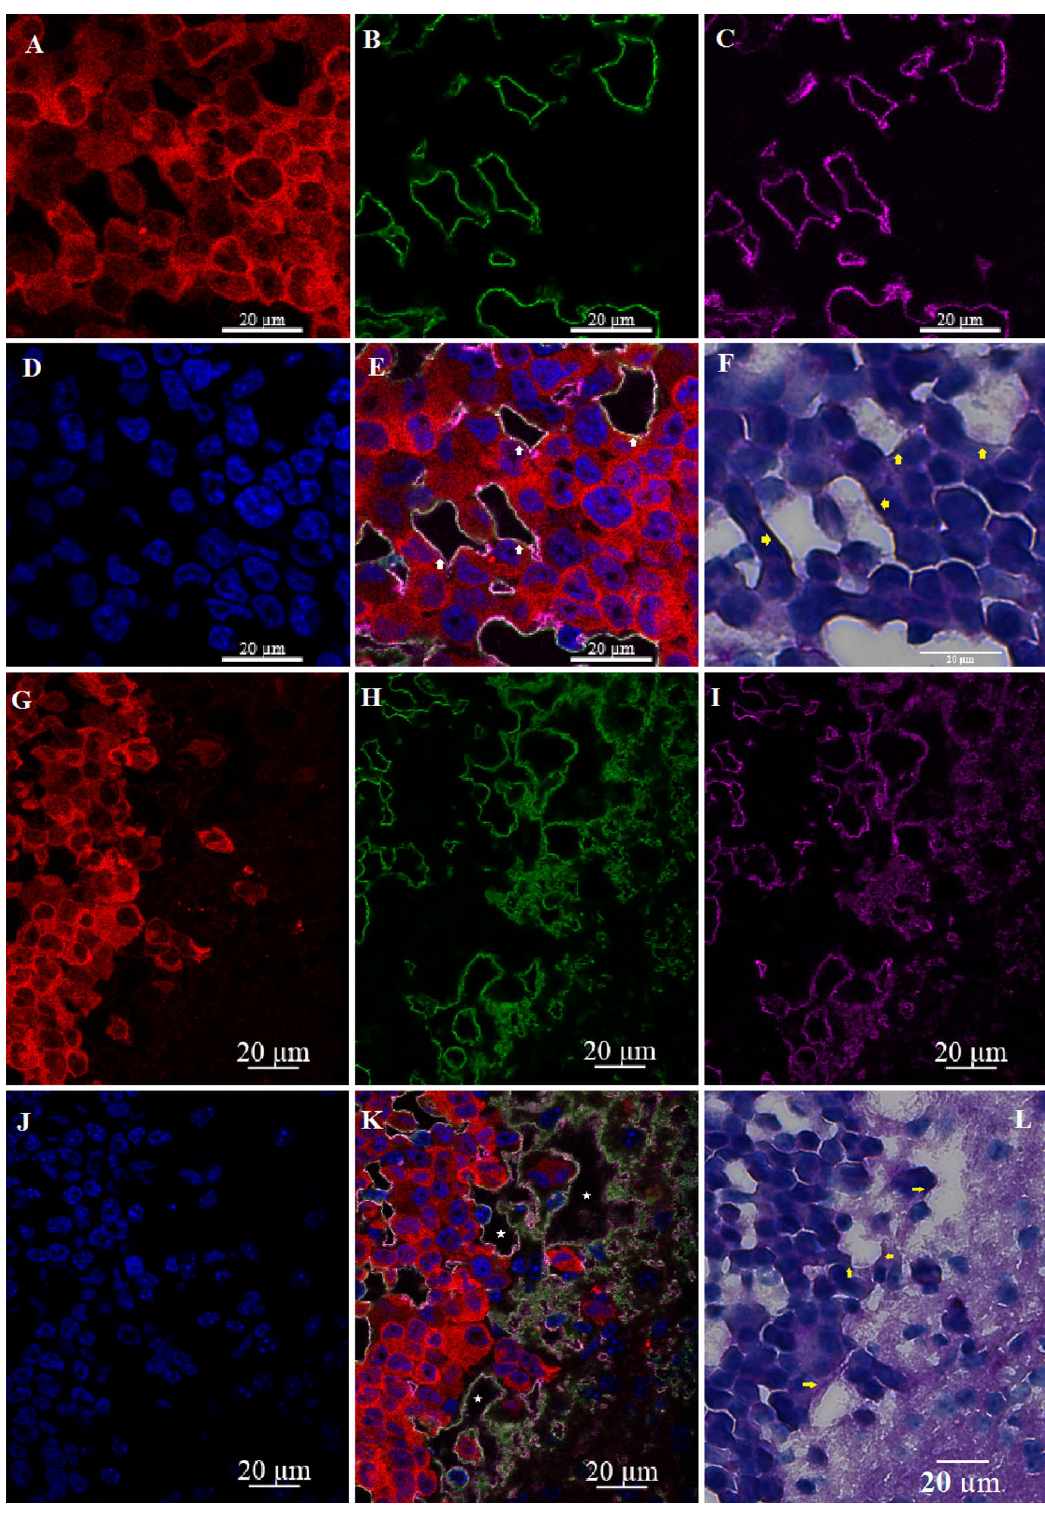
Figure 3. Irregularly shaped spaces (ISS) in the tumor ( A – F ) and at the tumor edge or active zone ( G – L ). A , G , Tumor cells (td-Tomato, red); B , H , INPs (antiPEG, green); C , I , Endothelial Stain (antiCD31, violet); E , K , All colors combined with Nuclei stained (Dapi, Blue); F , L (PAS stain). Yellow Arrows: Darkened PAS stain just outside of ISS. ISS (white arrows and asterisks) have all the hallmarks of vascular mimicry but are also bounded by CD31